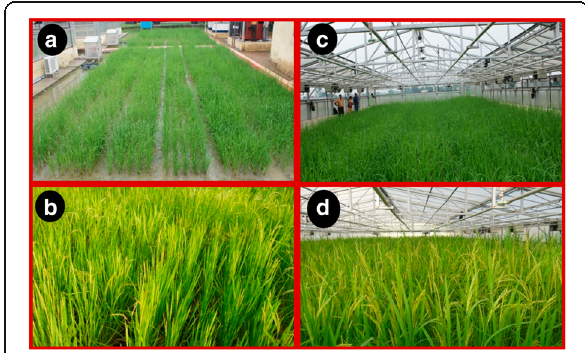
Fig. 1 Phenotyping of F 8 RIL mapping population under non-stress and heat stress conditions at ICAR-IIWBR. ( a ) At vegetative stage under non-stress condition ( b ). At reproductive stage under non-stress ( c ). At vegetative stage under non-stress condition inside controlled environment structure with roof top open ( d ). With reproductive stage heat stress for 10 days in controlled environment structure with roof top